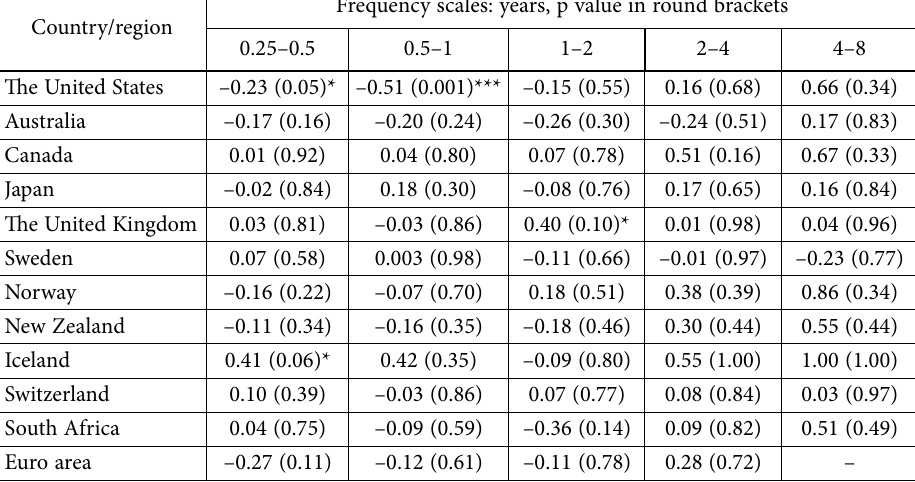
Table 3. Multiscale correlation between bank credit and stock prices based on the MODWT from 1Q 1984 to 4Q 2016 (source: own work)